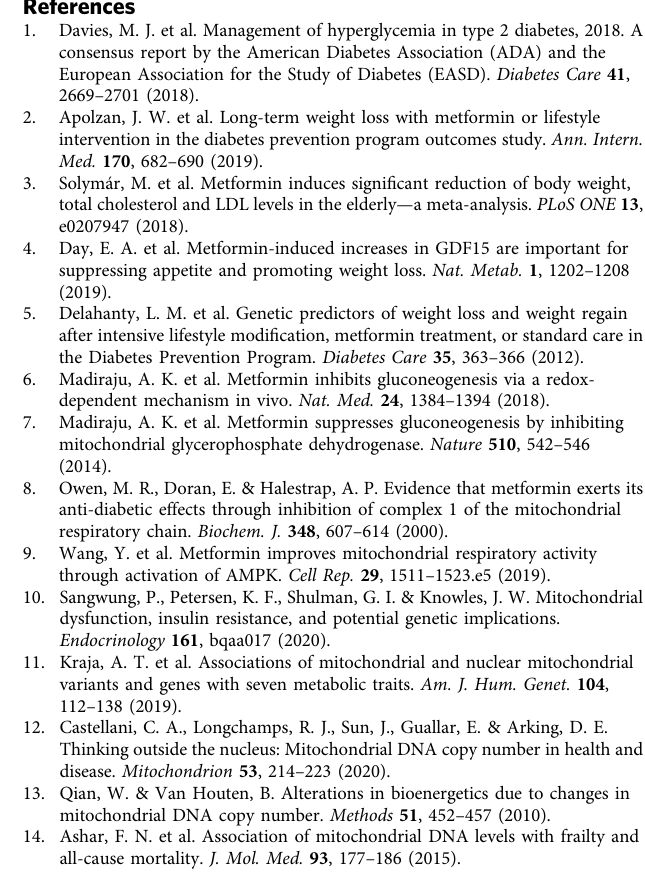
Table 3. Source data for Fig. 1 are available as Supplementary Data 1. As the part of the NyuWa genome resource, the WGS data of MARCH trial has been deposited at NODE (http://www.biosino.org/node) with accession number OEP002803. The WGS are available under restricted access due to participant consent and privacy regulations of NyuWa cohort, access can be obtained by request to the corresponding author (Kaixin Zhou: zhoukx@ucas.ac.cn), upon reasonable